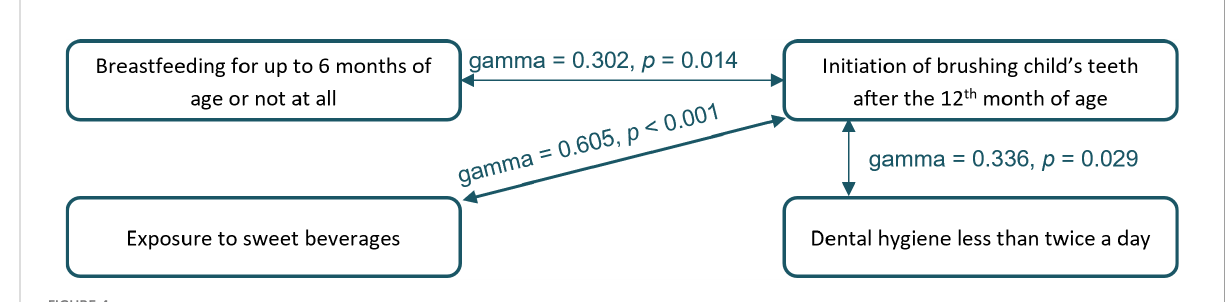
FIGURE 4 Signi fi cant relationships between behavioral risk factors for severe early childhood caries (sECC)